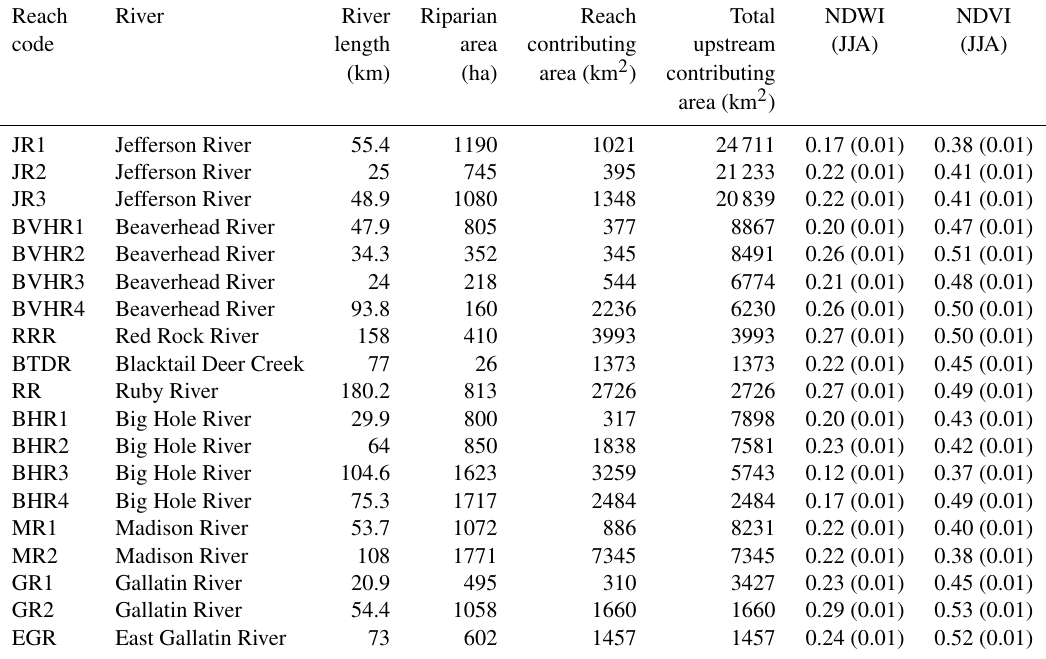
Table 2. Characteristics of each riparian reach considered, including river length, riparian area analyzed, riparian reach contributing area and average (1984–2016) growing-season (June, July and August – JJA) normalized difference wetness index (NDWI) and normalized difference vegetation index (NDVI). Standard error shown in